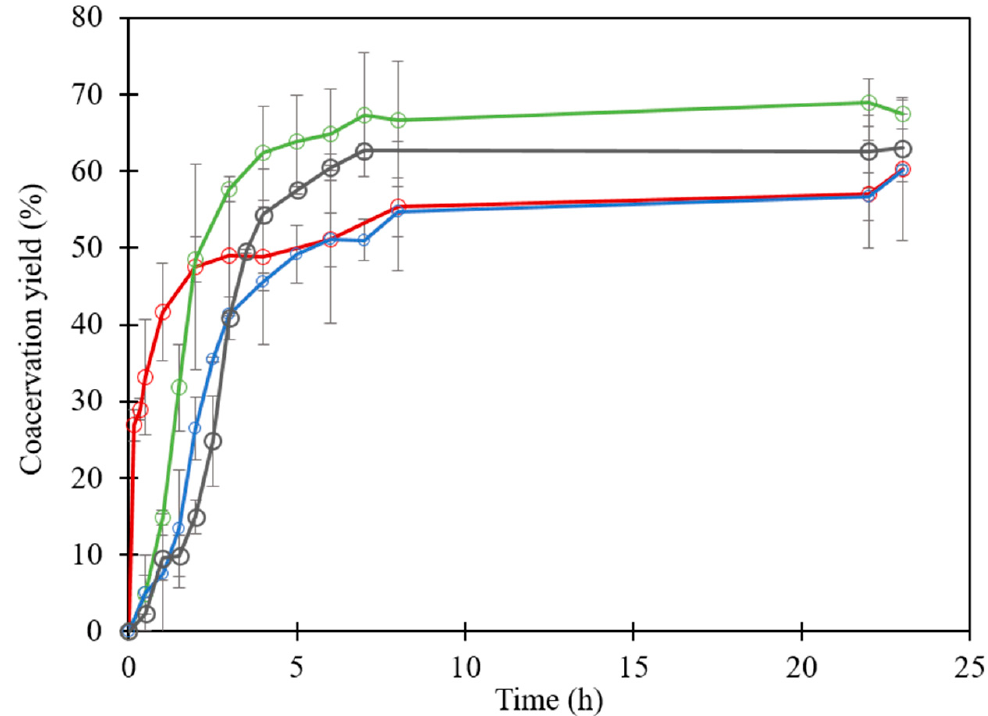
Figure 7. Evolution of the coacervate yield inside the dialysis tube during desalting experiment of lactoferrin– β -lactoglobulin mixed at total protein concentration of 0.55 mM in 10 mM MES buffer, pH 5.5 at various initial salt concentrations. No added salt ( red ); with added NaCl at concentrations of 100 mM ( green ), 200 mM ( blue ) and 400 mM ( black ).